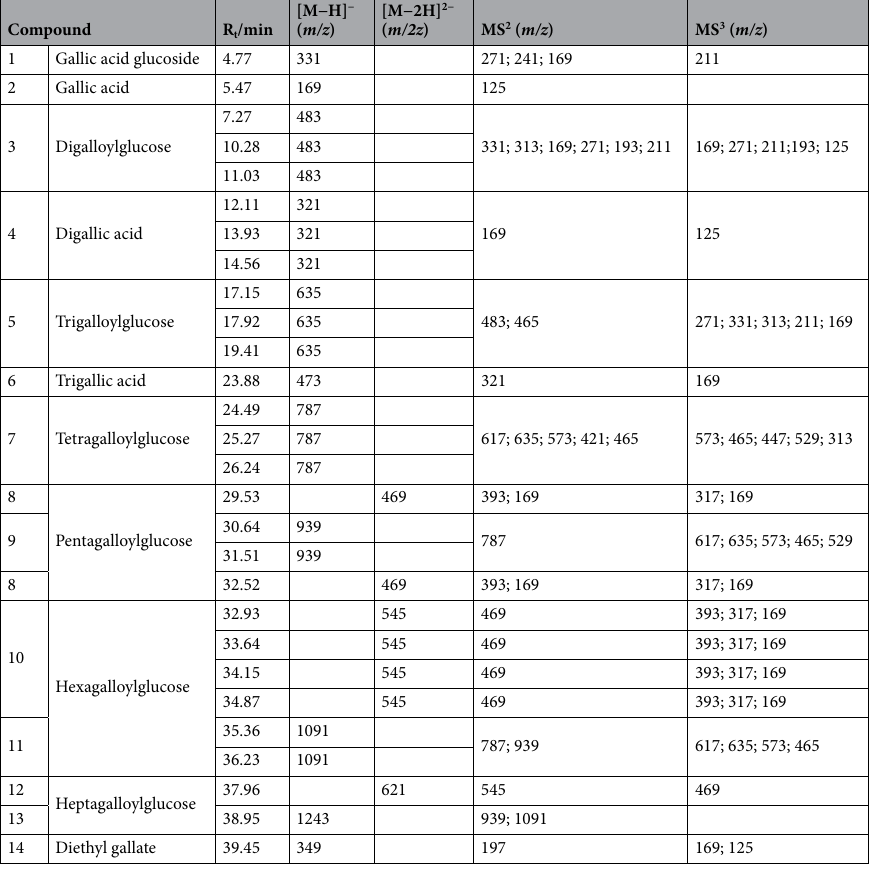
Table 2. HPLC–ESI–MS identification of the phenolic compounds present in the Braga